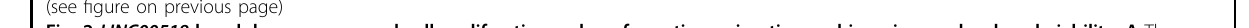
Fig. 2 LINC00518 knockdown suppressed cell proliferation, colony formation, migration and invasion, and reduced viability. A The gene chip data related to LINC00518 were upregulated in T group (CMM tissues, n = 73) compared with N group in GSE46517 data set (normal tissues, n = 17). B qPCR assay showing that LINC00518 was overexpressed in 12 paired CMM tissues and their corresponding adjacent noncancerous skin tissues obtained from tissue biopsy samples in our study. C qPCR assay showing that LINC00518 expression was higher in WM451 and A375 cells, which have high invasive and metastatic tendency; however, it was lower in HM (normal melanocyte cell lines) and WM35 (low invasive and metastatic tendency) cells. The expression data in HM were considered as a control. D qPCR assay demonstrating shLINC00518 knockdown of LINC00518 in WM451 and A375 cell lines. E MTT assay indicating that LINC00518 knockdown in WM451/A375 cells decreased viability signi fi cantly compared with that in control cells. F Flow cytometry examination showing that LINC00518 knockdown could increase apoptosis of CMM cells. G Colony formation assay indicating that knockdown of LINC00518 could suppress cell proliferation in CMM cells. H Transwell assay showing the effect on CMM cell migration following LINC00518 knockdown. I Wound-healing assay showing that LINC00518 knockdown in WM451/A375 cells can signi fi cantly inhibit cell migration compared with the control. The histogram data for each group are an average of three independent replicates; bars indicate SD; * P < 0.05, ** P < 0.01, *** P <